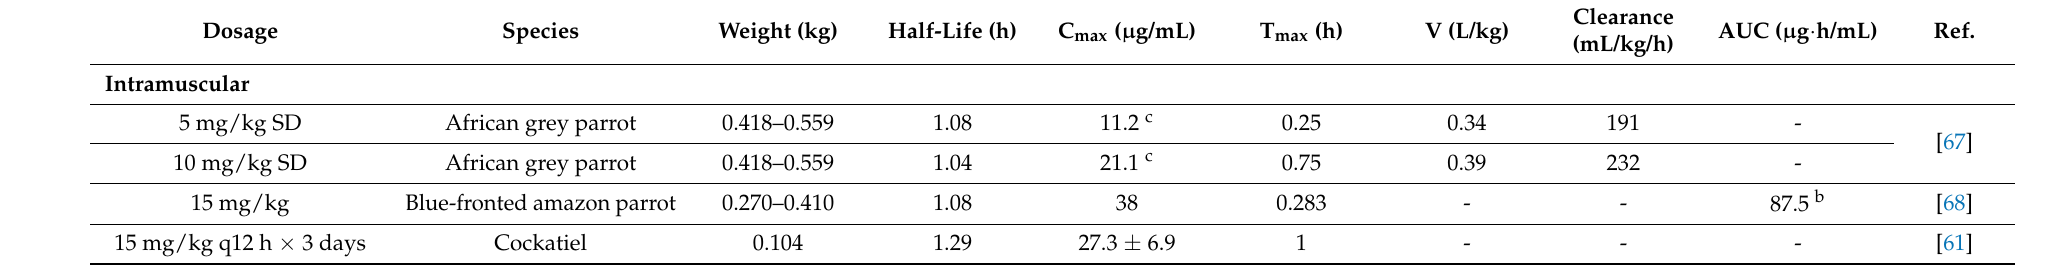
Table 9. Pharmacokinetic values for amikacin in exotic avian